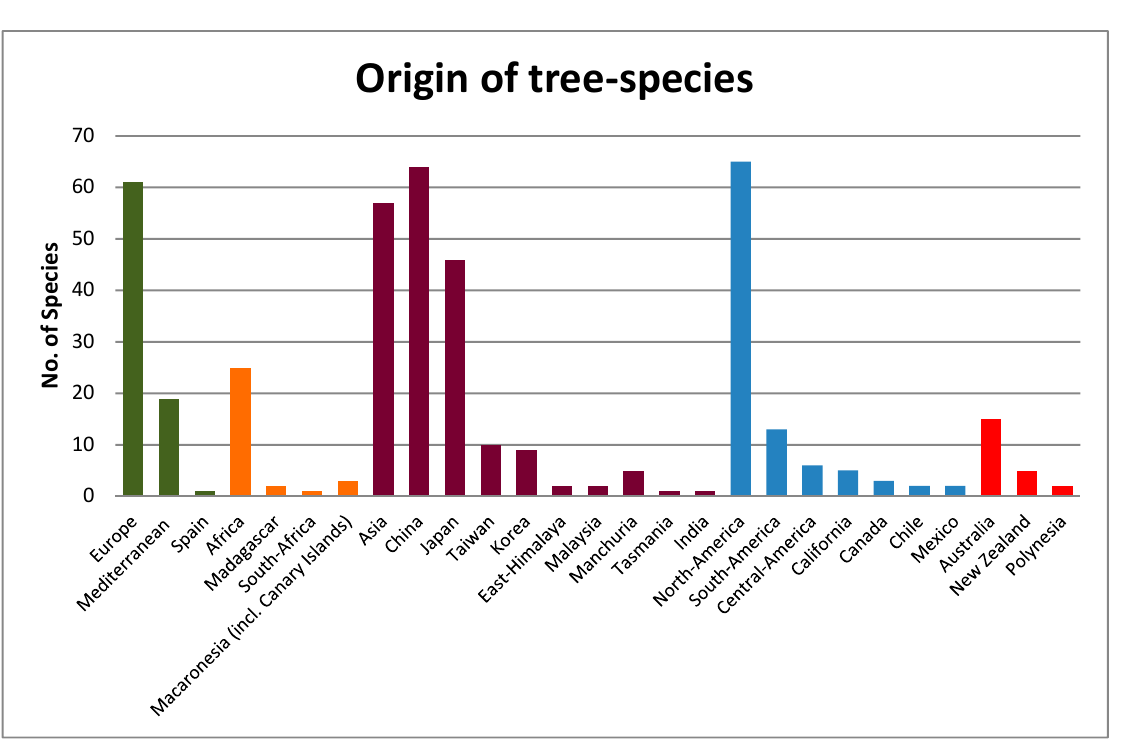
Figure 2. Geographical origin of the tree species found in the parks.